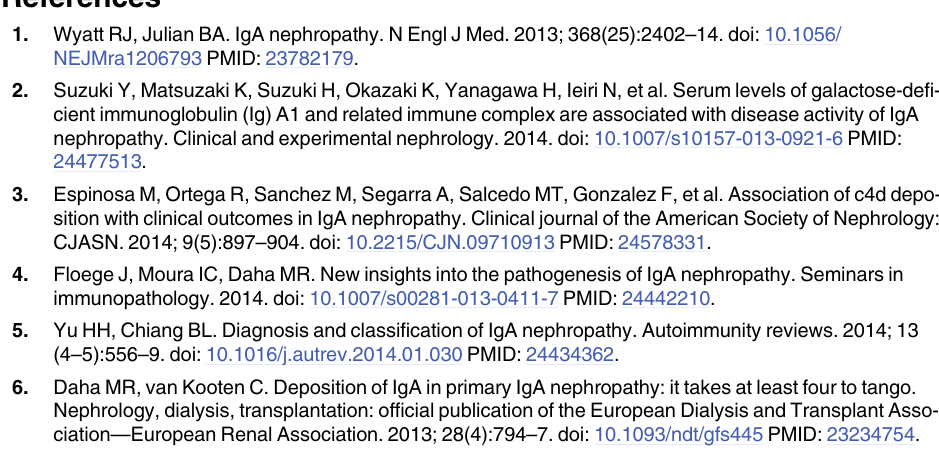
S1 Table. Clinical and SNP data for patients and